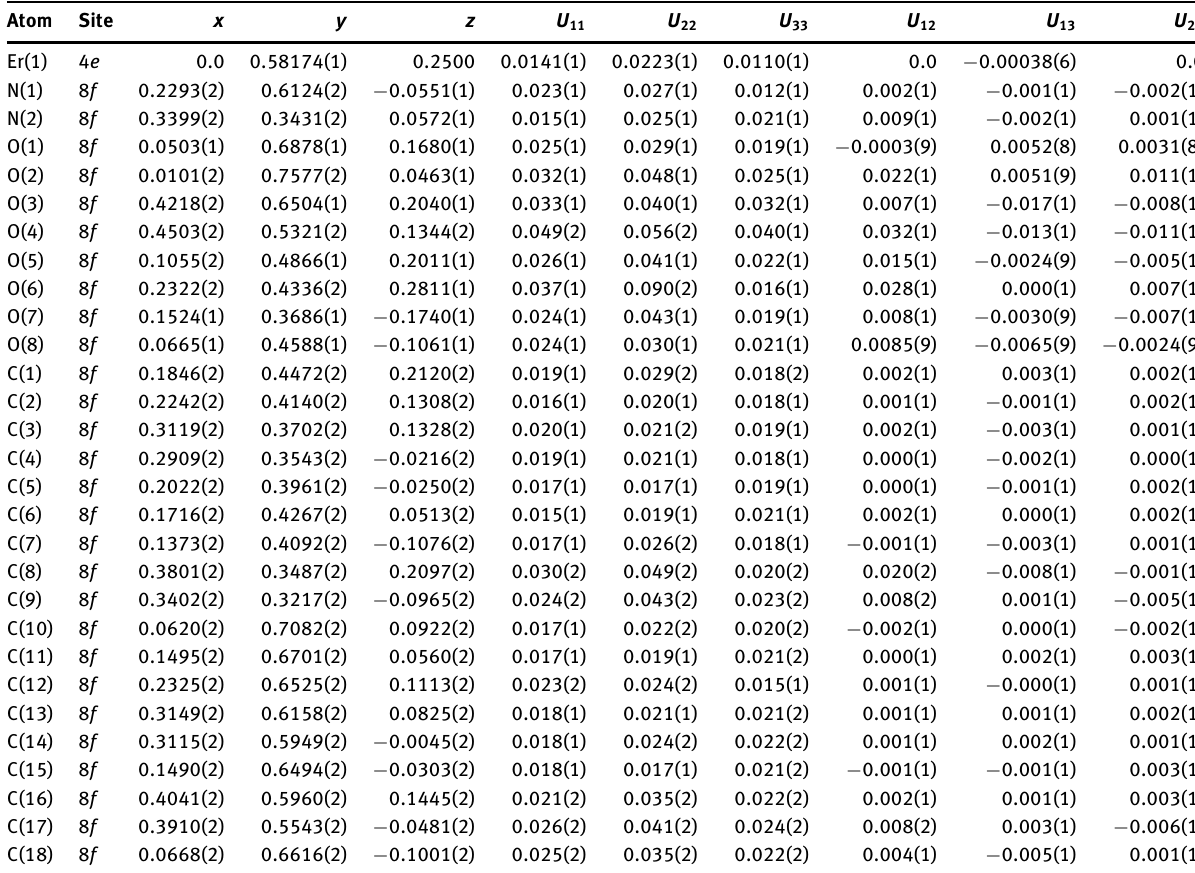
Table 3: Fractional coordinates and atomic displacement parameters (Å 2